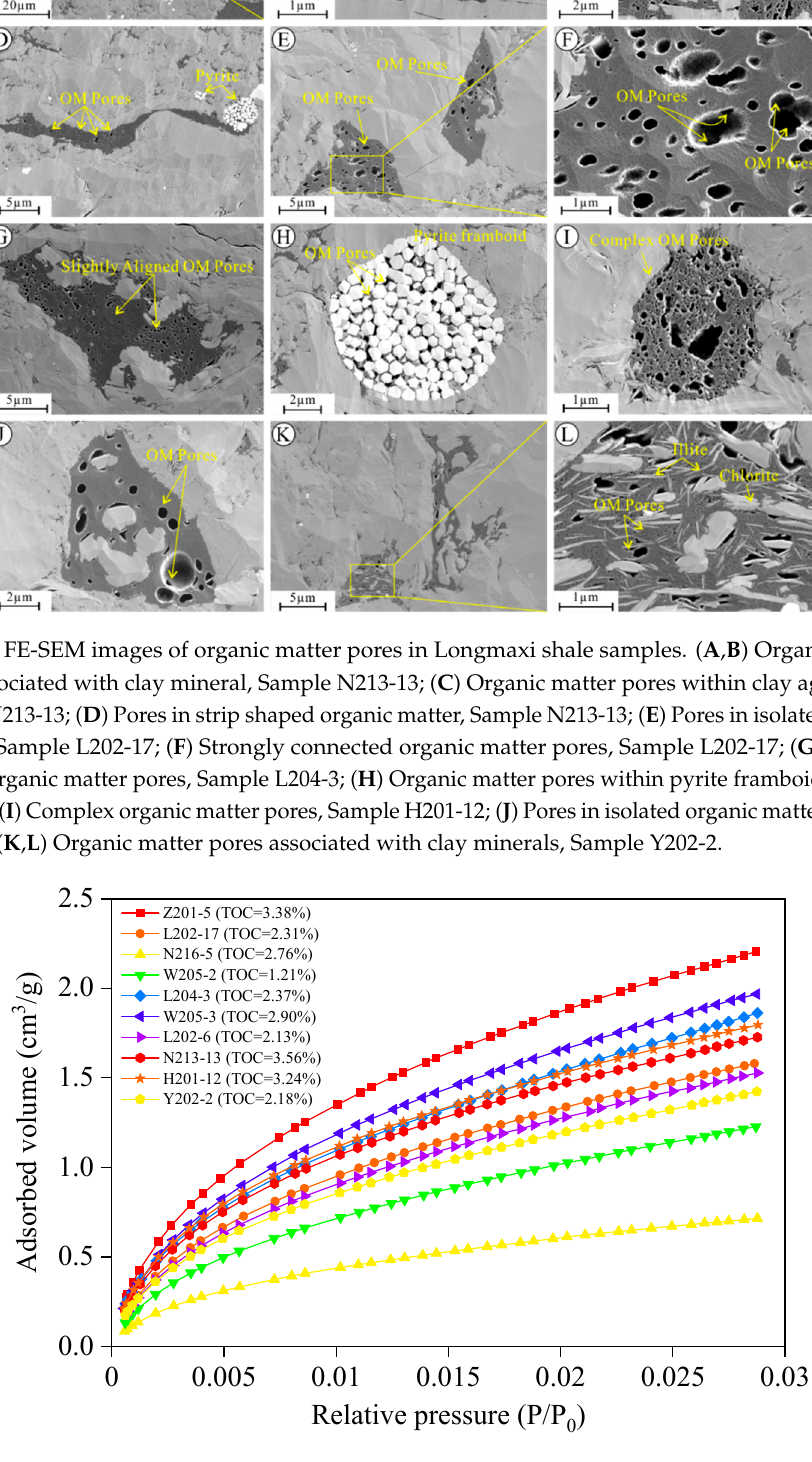
Figure 6. CO 2 adsorption isotherms of Longmaxi shale samples.